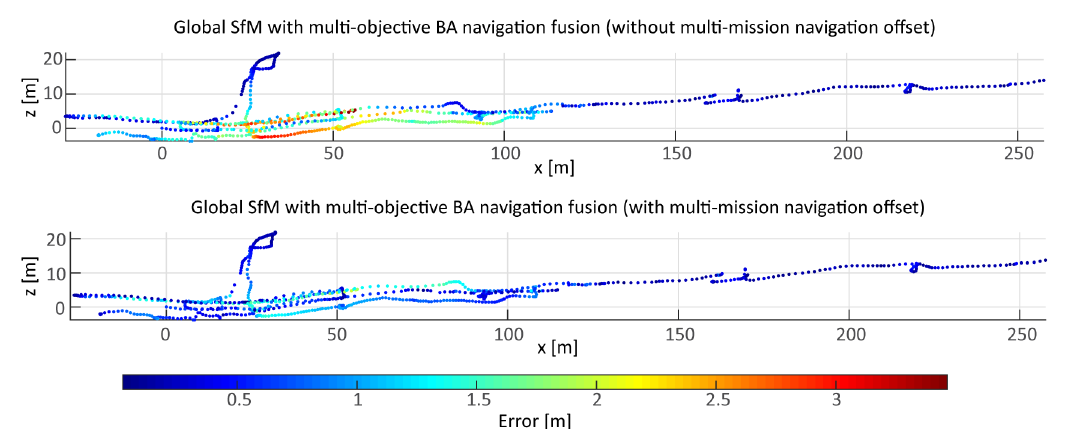
Figure 27. Comparison of the effects of multisurvey data fusion strategies on the estimated camera path.